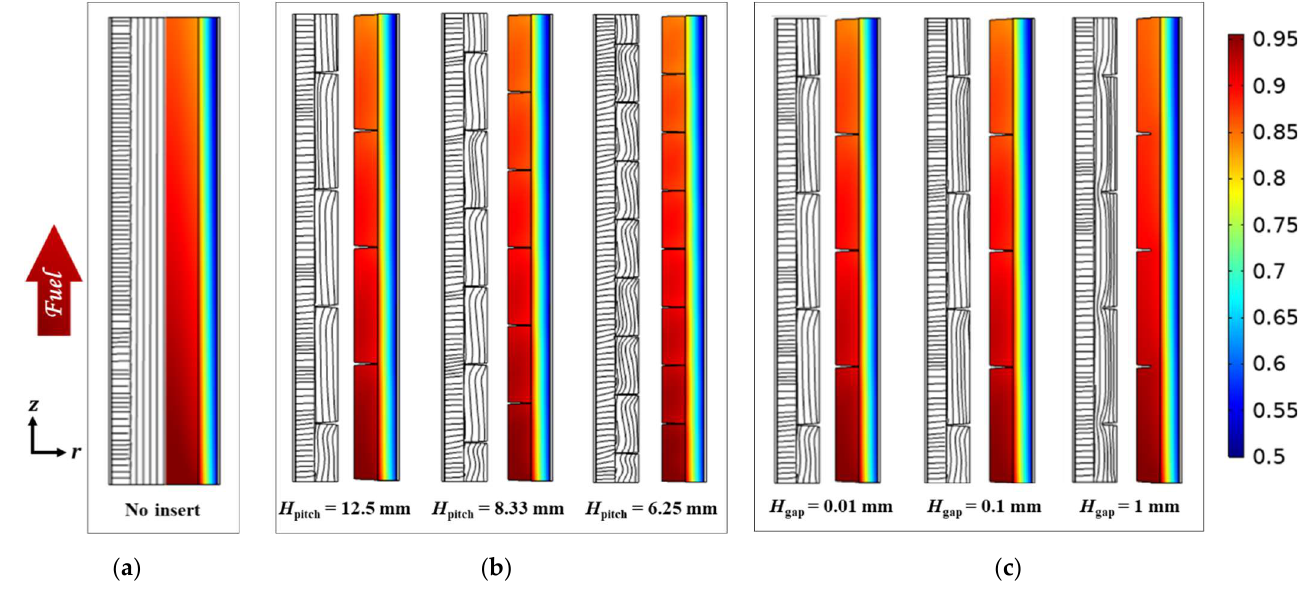
Figure 13. The streamlines ( left ) and CO mole fractions ( right ) of the micro-tubular SOFCs ( a ) without an insert; and with helical screw inserts of different ( b ) pitches ( c ) gaps.